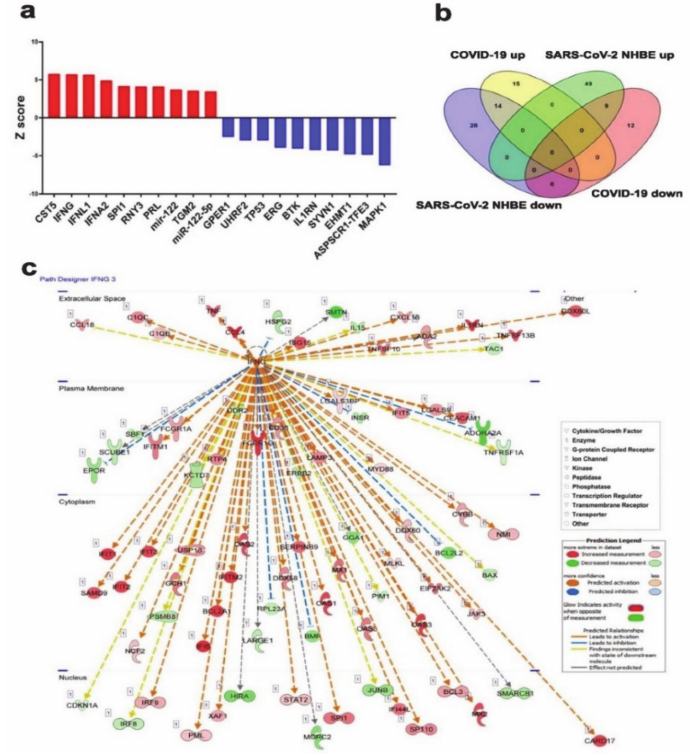
Figure 6. Mechanistic Network Analysis Predicts central role for IFNG in the host response of patients with COVID-19 infection. ( a ) Top ten activated and top ten inhibited upstream regulator networks in lung tissue derived from COVID-19 patients based on transcriptome and IPA analyses. ( b ) Venn diagram illustrating the overlap between activated and suppressed upstream regulator networks in SARS-COV-2 NHBE and lung tissue from COVID-19 patients based on RNA-seq and IPA analysis. ( c ) Illustration of the IFNG mechanistic network according to subcellular localization. Activation state is depicted according to color